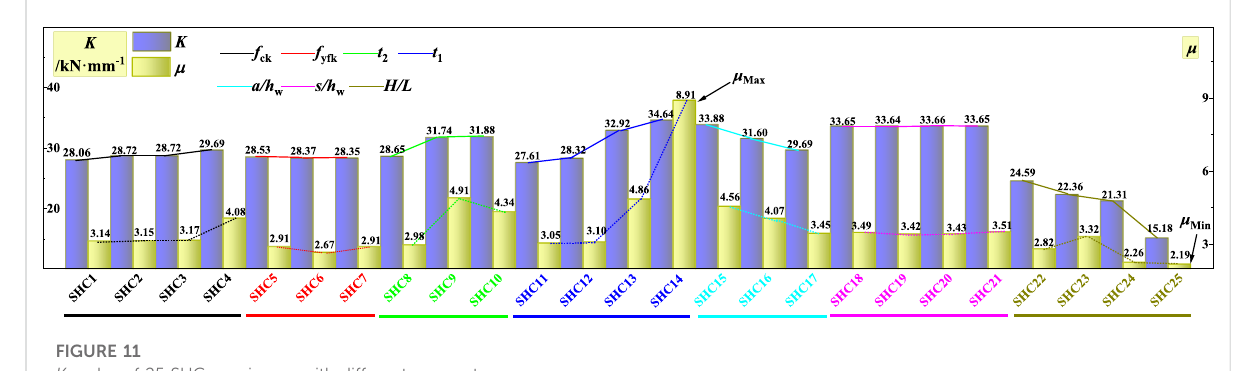
FIGURE 11 K and µ of 25 SHC specimens with different parameters.